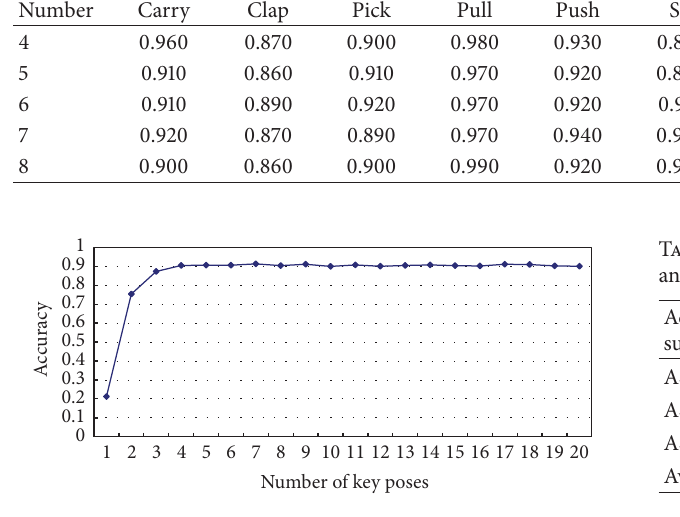
Table 5: Comparison of our method with the others on MSR